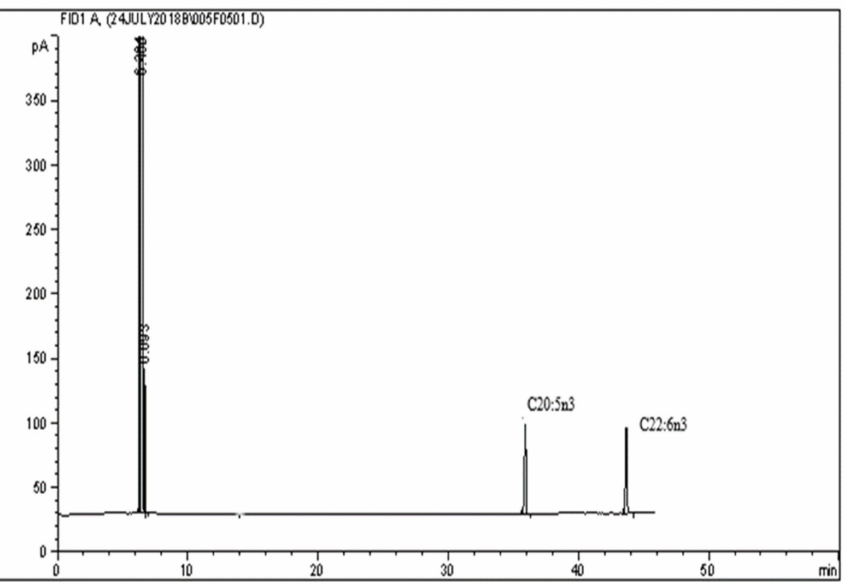
Figure 2. GC chromatogram of 1 µ L of 5 mg/mL of EPA and DHA standards injected into the